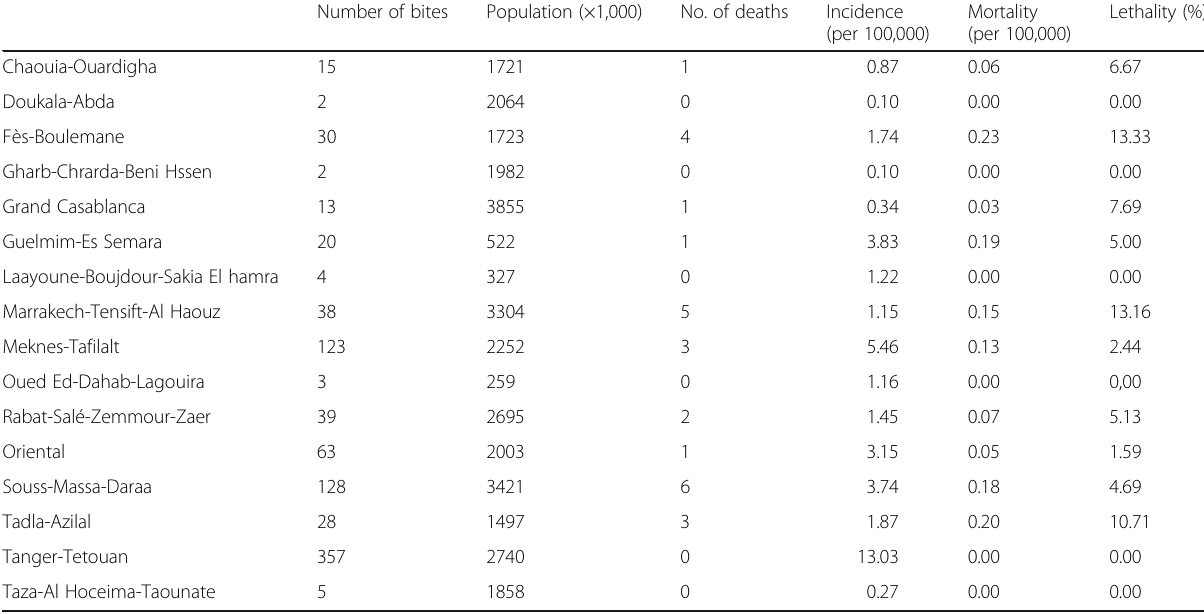
Table 1 Annual incidence and mortality according to the Moroccan regions (data from CAPM, 2009 – 2013) Number of